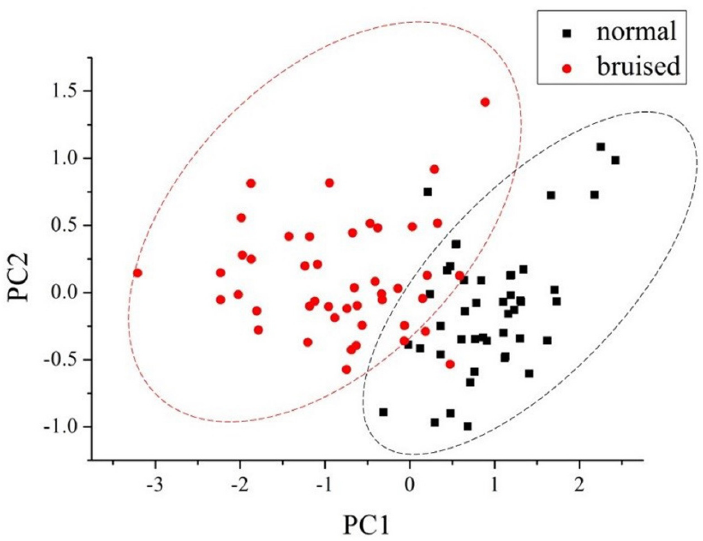
Figure 4. Principal component analysis (PCA) scores plots (PC1 vs. PC2) for modeling samples (45 normal samples in black and 45 bruised samples in red.